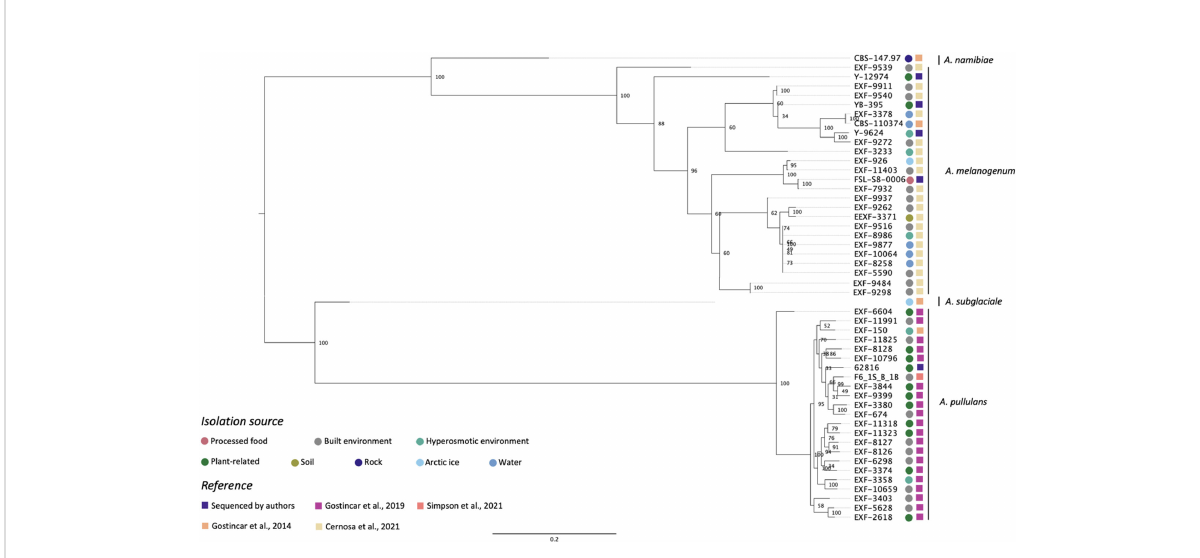
FIGURE 1 Phylogenetic relationships among Aureobasidium strains inferred from SNP alignment. Bootstrap values observed among 1,000 replicates are indicated. The phylogenetic tree was midpoint rooted and the scale bar denotes the number of nucleotide substitutions per